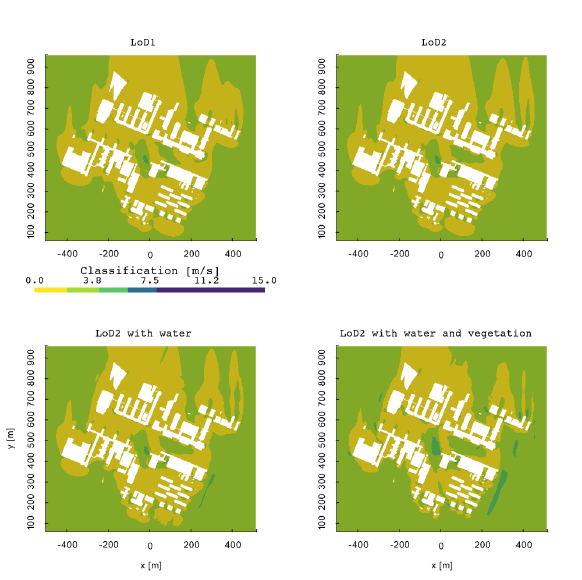
Figure 7. Pedestrian wind comfort classification at 1.75 m